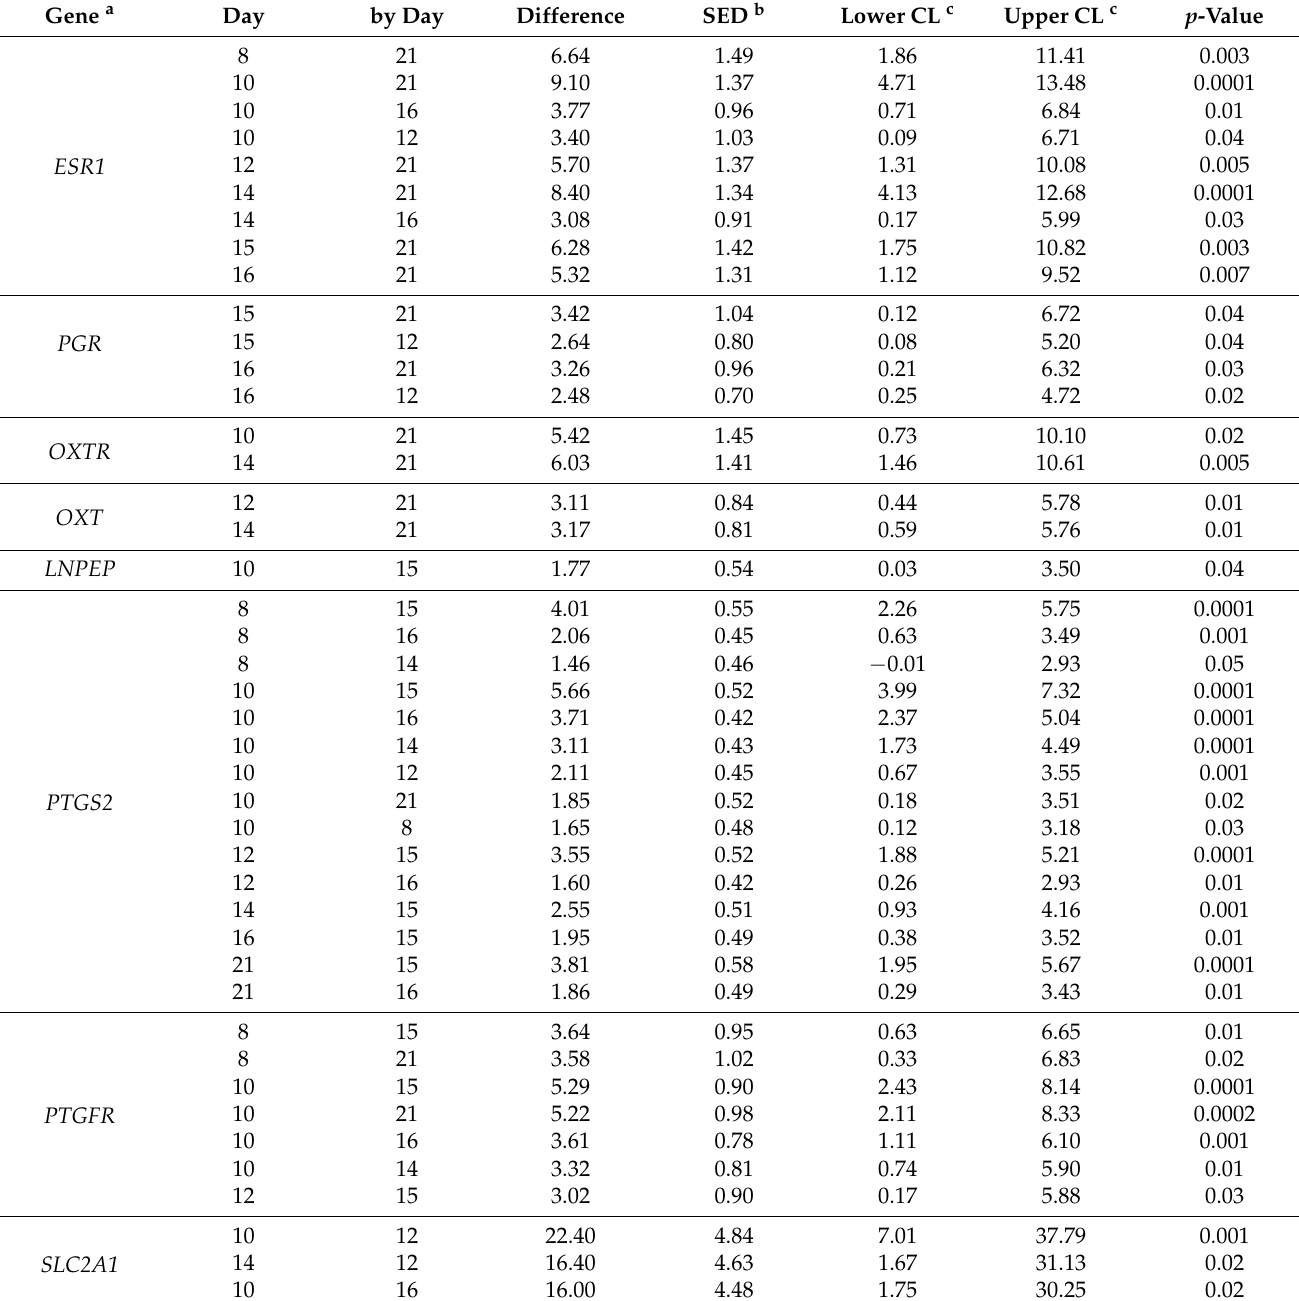
Table 2. Comparisons by day post-ovulation of selected equine embryonic genes at p < 0.05. Gene